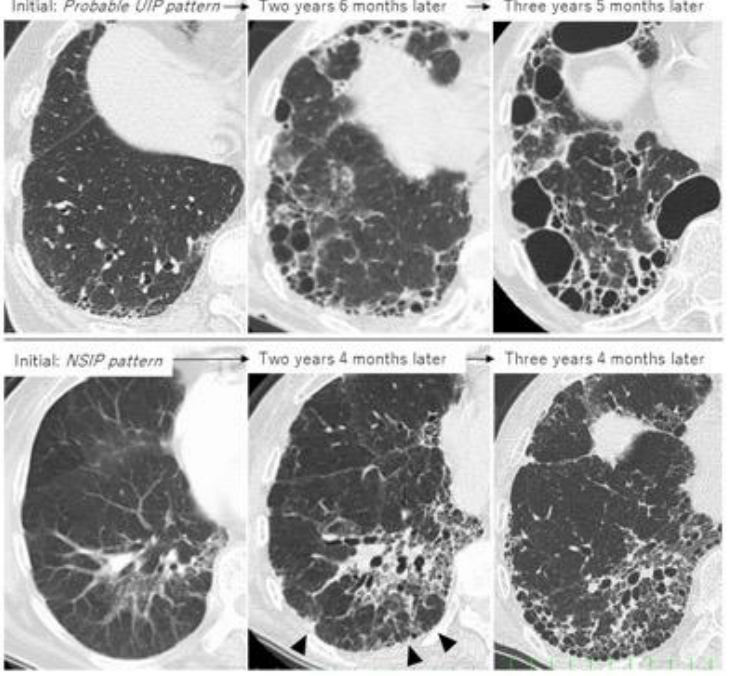
Figure 6. Two cases of progressive RA-ILD showing the evolution of honeycombing during fol- low-up. Upper row: probable UIP pattern at initial imaging; lower row: NSIP pattern at initial imaging (arrowhead indicates UIP-like lesion formation as subpleural reticulation).